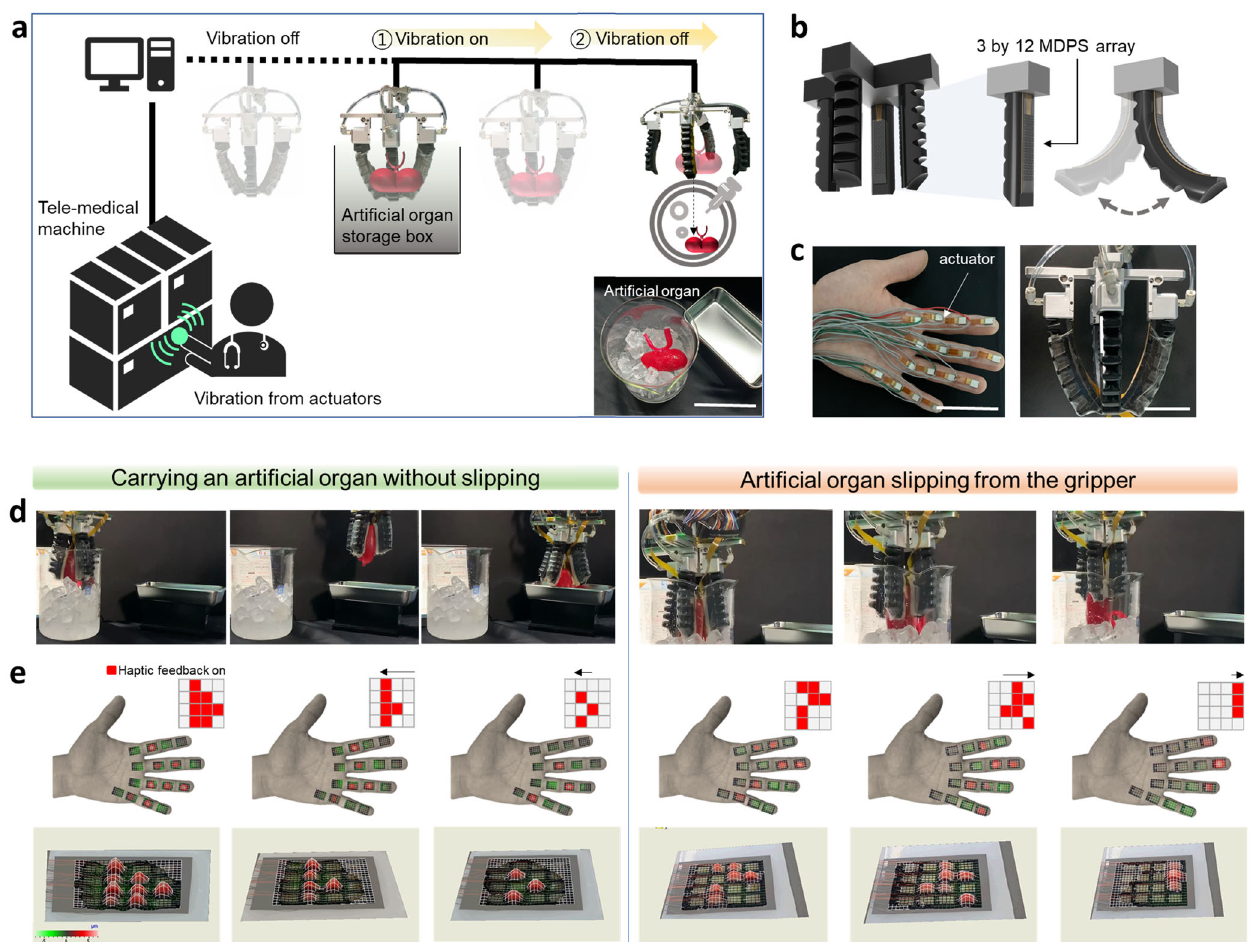
Fig. 5 Tele-haptic system demonstration. a Schematics of integrated tele-haptic system interacting operators and soft grippers. Real image of an arti fi cial organ in the storage box (inset). Scale bar, 10 cm. b Schematics of MDPS attached on a soft gripper with 4 fi ngers. c Photos of actuators and the pneumatic soft gripper. Scale bars, 5 cm. d Sequential images of two different tele-medical situations. e Displacement of vibrating actuators tracked by laser scanning vibrometer under